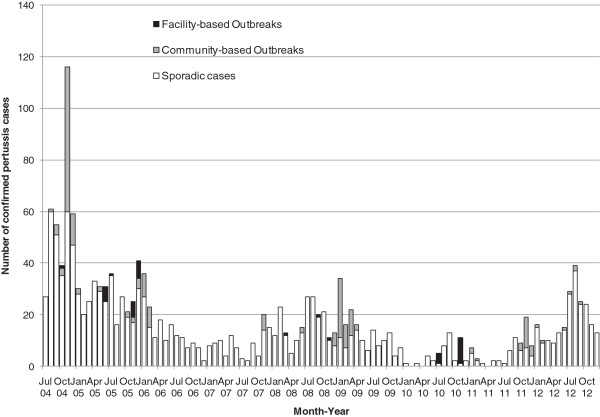
Monthly distribution of confirmed
B. pertussis
cases by the type of setting: sporadic, community-based and facility-based outbreaks in Alberta (July 2004 – December 2012).